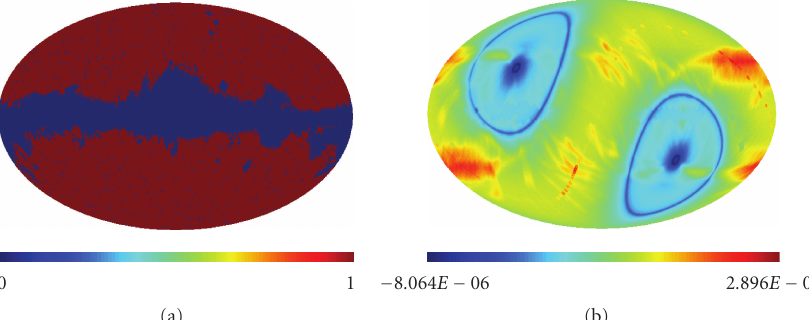
Figure 9: (a) The KQ75 galactic and point-source mask used for non-Gaussian analysis of WMAP data. (b) Anisotropic distribution of the noise for a coadded map of the WMAP V and W frequency channels. These two features break rotational invariance of the observed CMB sky and spoil the optimality of the standard cubic statistic (72), unless an additional “linear term” is included, as explained in the main text. Data are obtained from the LAMBDA website,